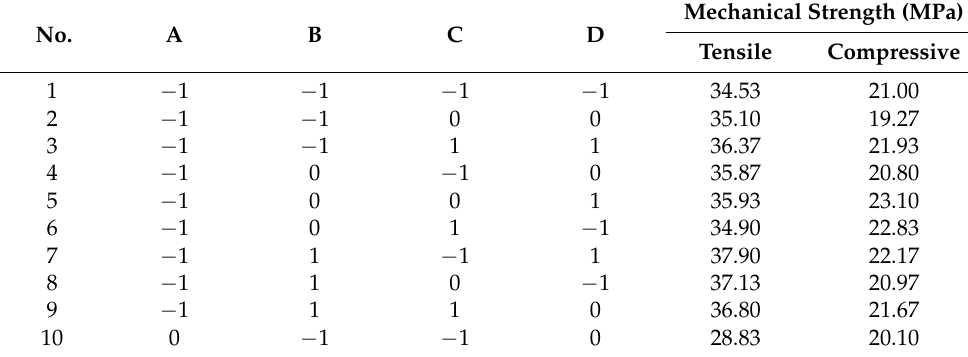
Table 3. Design of matrix L 27 (3 13 ).